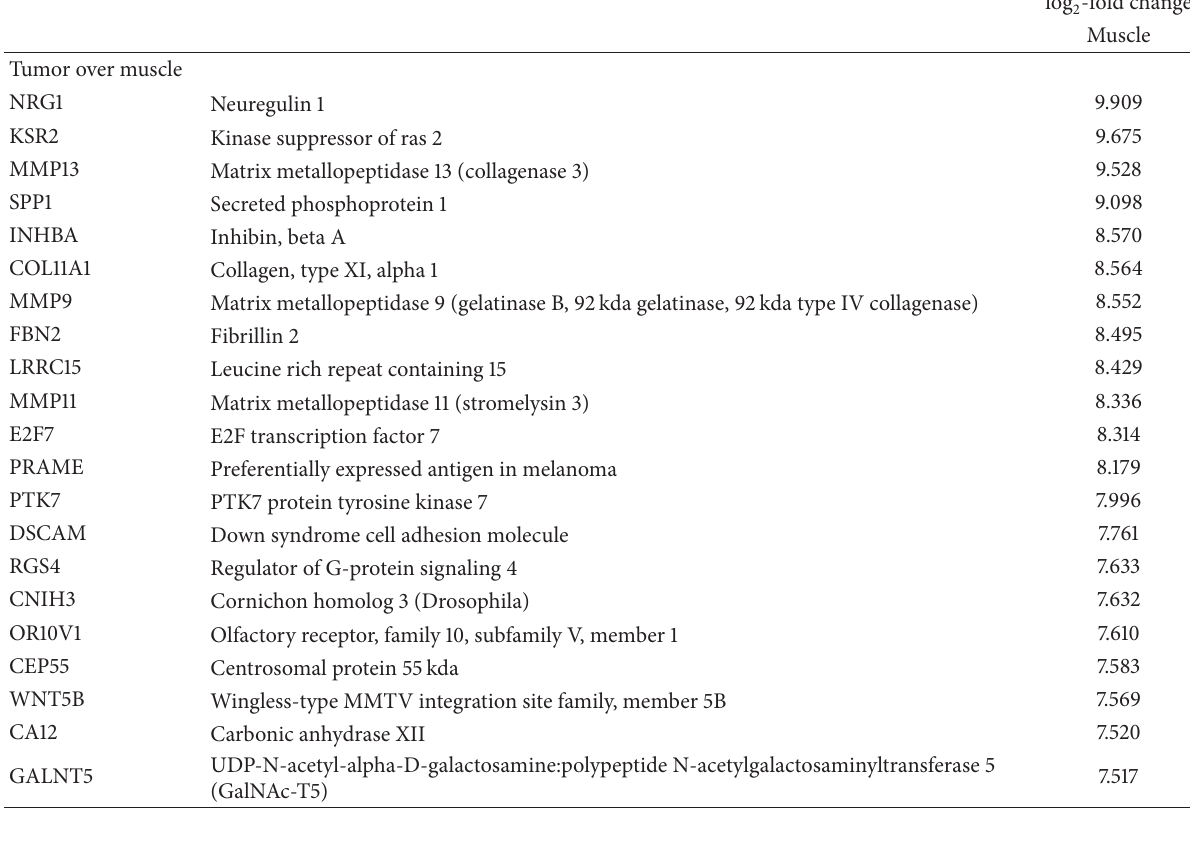
Table 2: RNA induced in the tumor. (a) Transcripts overexpressed in the tumor compared to muscle but not bone. (b) Transcripts overexpressed in the tumor compared to bone but not muscle. (c) Transcripts most abundantly overexpressed in the tumor compared to muscle and bone. (d) as (a) but limited to genes expressed at least at the level of 1 unit in the reference tissue (muscle or bone). (e) Altered expression of genes associated with NF- 𝜅 B activity. Analysis of RNASeq for the transcription factor NF- 𝜅 B and gene products that regulate its -fold change activity. RNA messages that are selectively associated with the TNF pathway to NF- 𝜅 B activation are marked with bold font. log 2 indicates the alteration in the tumor compared to muscle or bone (the respective columns indicate the expression level for each organ). (a) log -fold 2